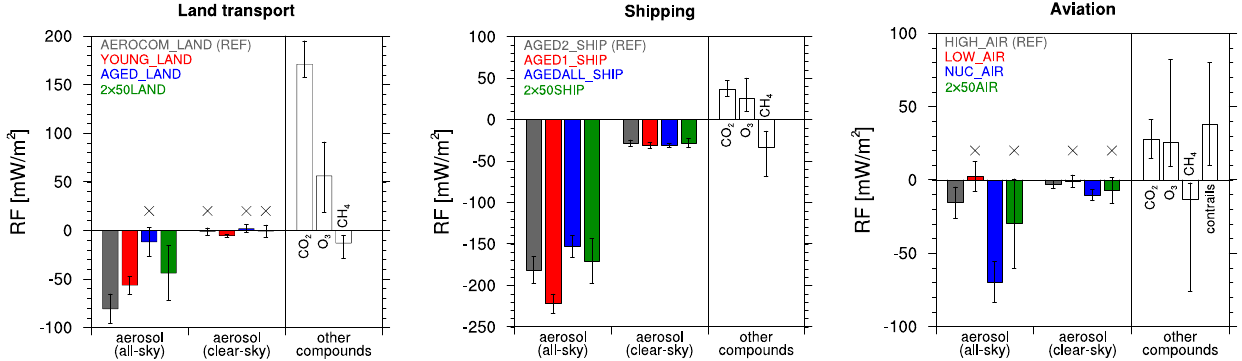
Fig. 12. Multi-year average (1996–2005) all-sky and clear-sky radiative forcings (in units of mWm − 2 ) of transport-induced aerosol pertur- bations calculated for the different model experiments. Non-significant values according to a uni-variate t test (5% error probability) are marked with the × symbol. The error bars refer to the 95% confidence intervals, based on the interannual variability of the forcings. The white bars on the right side of each panel represent the RF for CO 2 , ozone, methane and for contrail cirrus in the aviation case, as derived from other studies (see text for the corresponding references). Note the different vertical